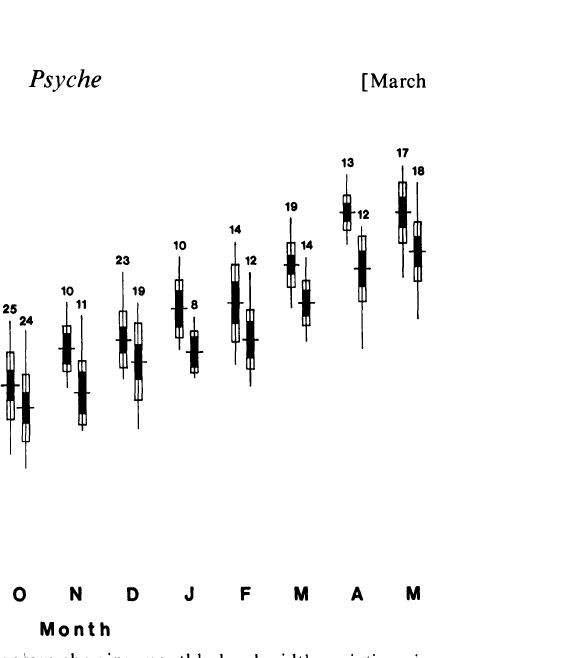
Figure 2. Population range diag,’am showing monthly head width variations in B. hq/kovi nymphs, Beech Fork of Twelvepole Creek, Wayne County, West Virginia, 1976’-77. Vertical lines range, horizontal lines mean, open rectangles-- one standard deviation, dark rectangles two standard errors of the mean, numbers sample size, females, m